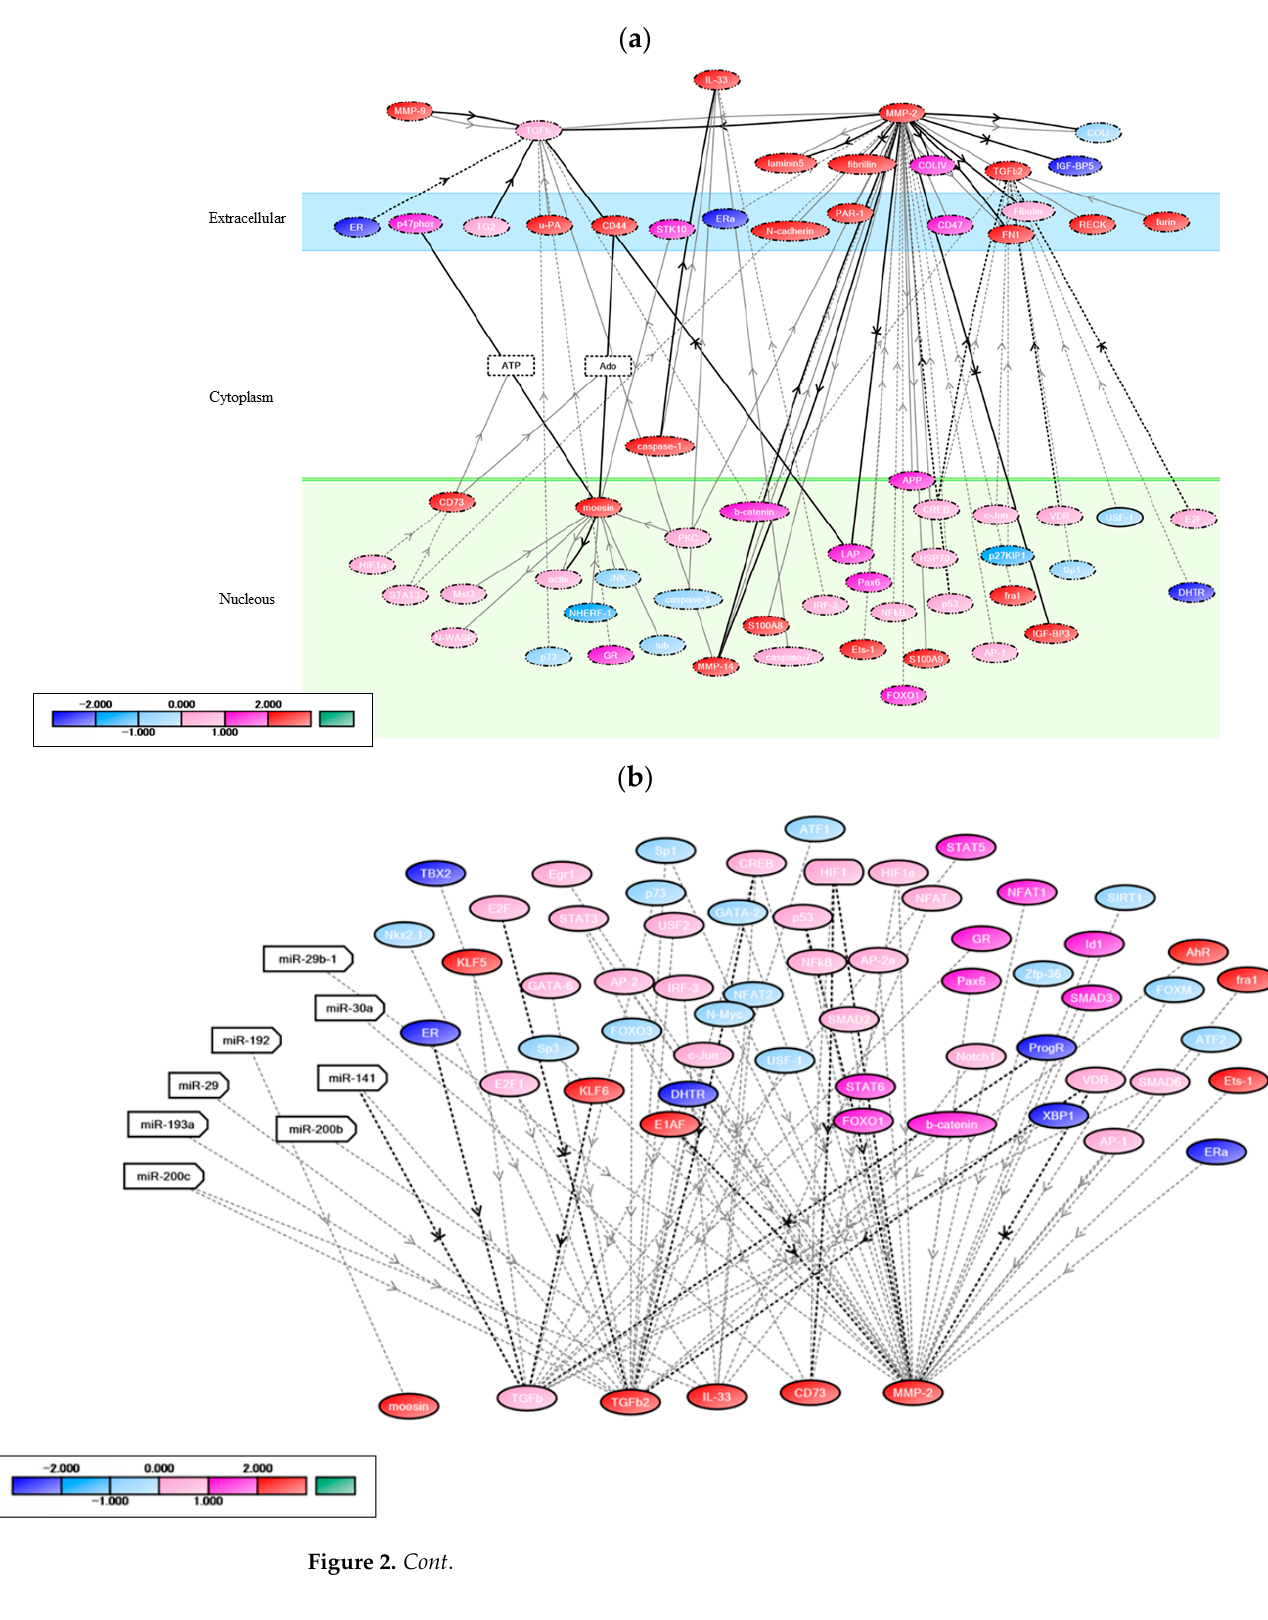
( c ) Figure 2. Cont